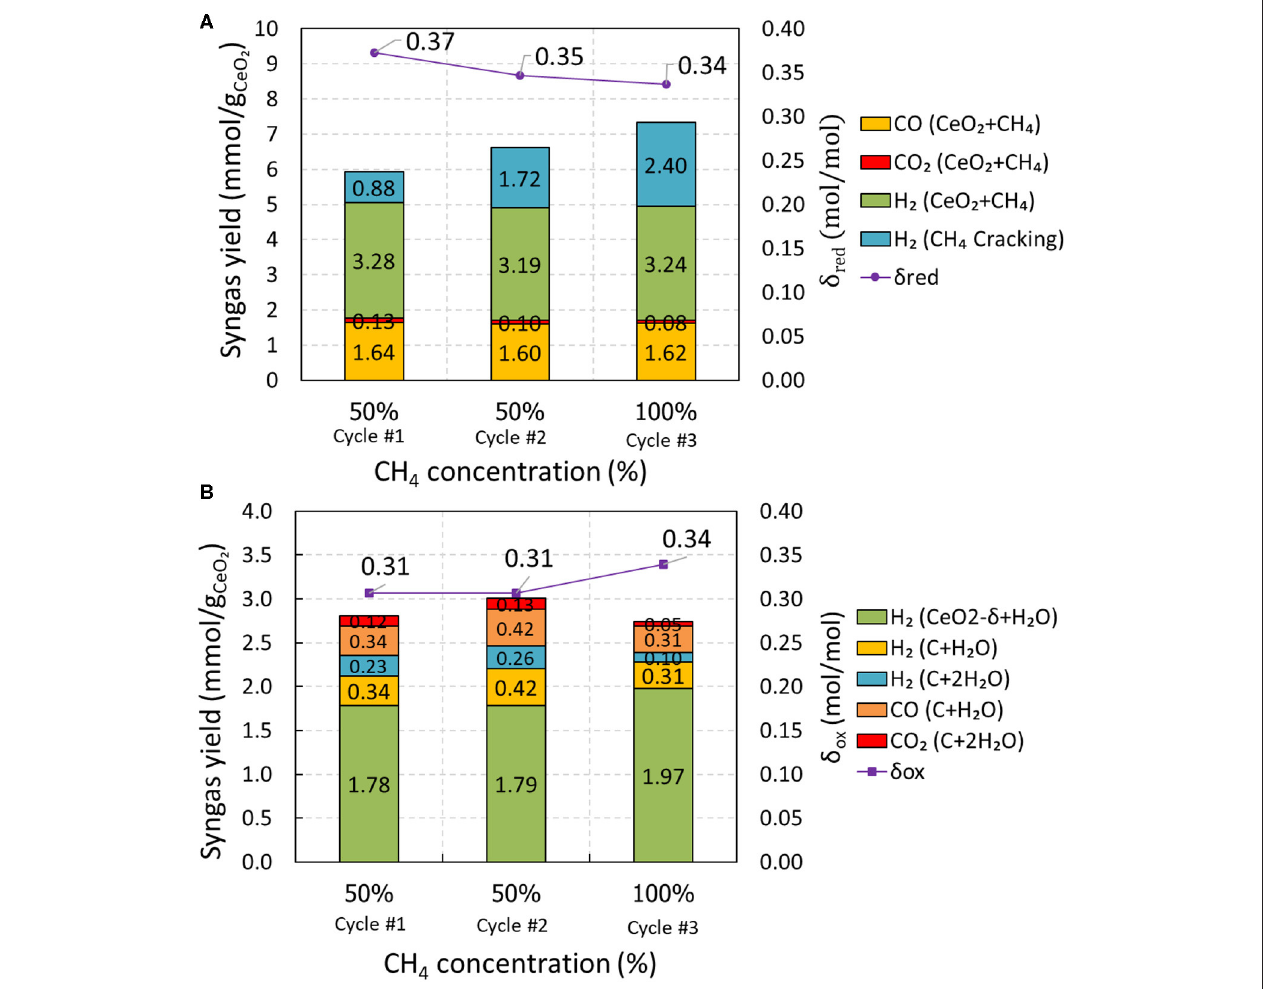
FIGURE 7 | Syngas yield and δ for (A) reduction and (B) oxidation of ceria foam cycled isothermally at 1,000 ◦ C as a function of inlet CH 4 concentration.